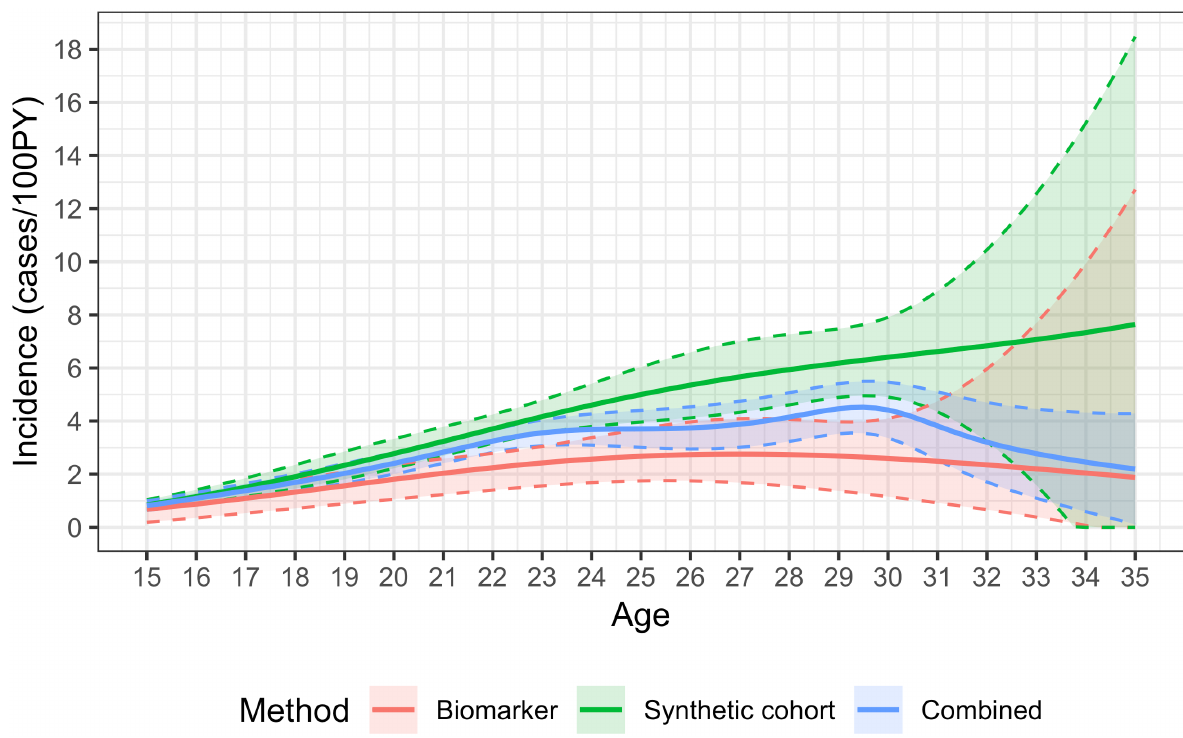
Fig 4. HIV incidence by age in males and females aged 15-35, using the synthetic cohort, recency biomarker and combined methods.